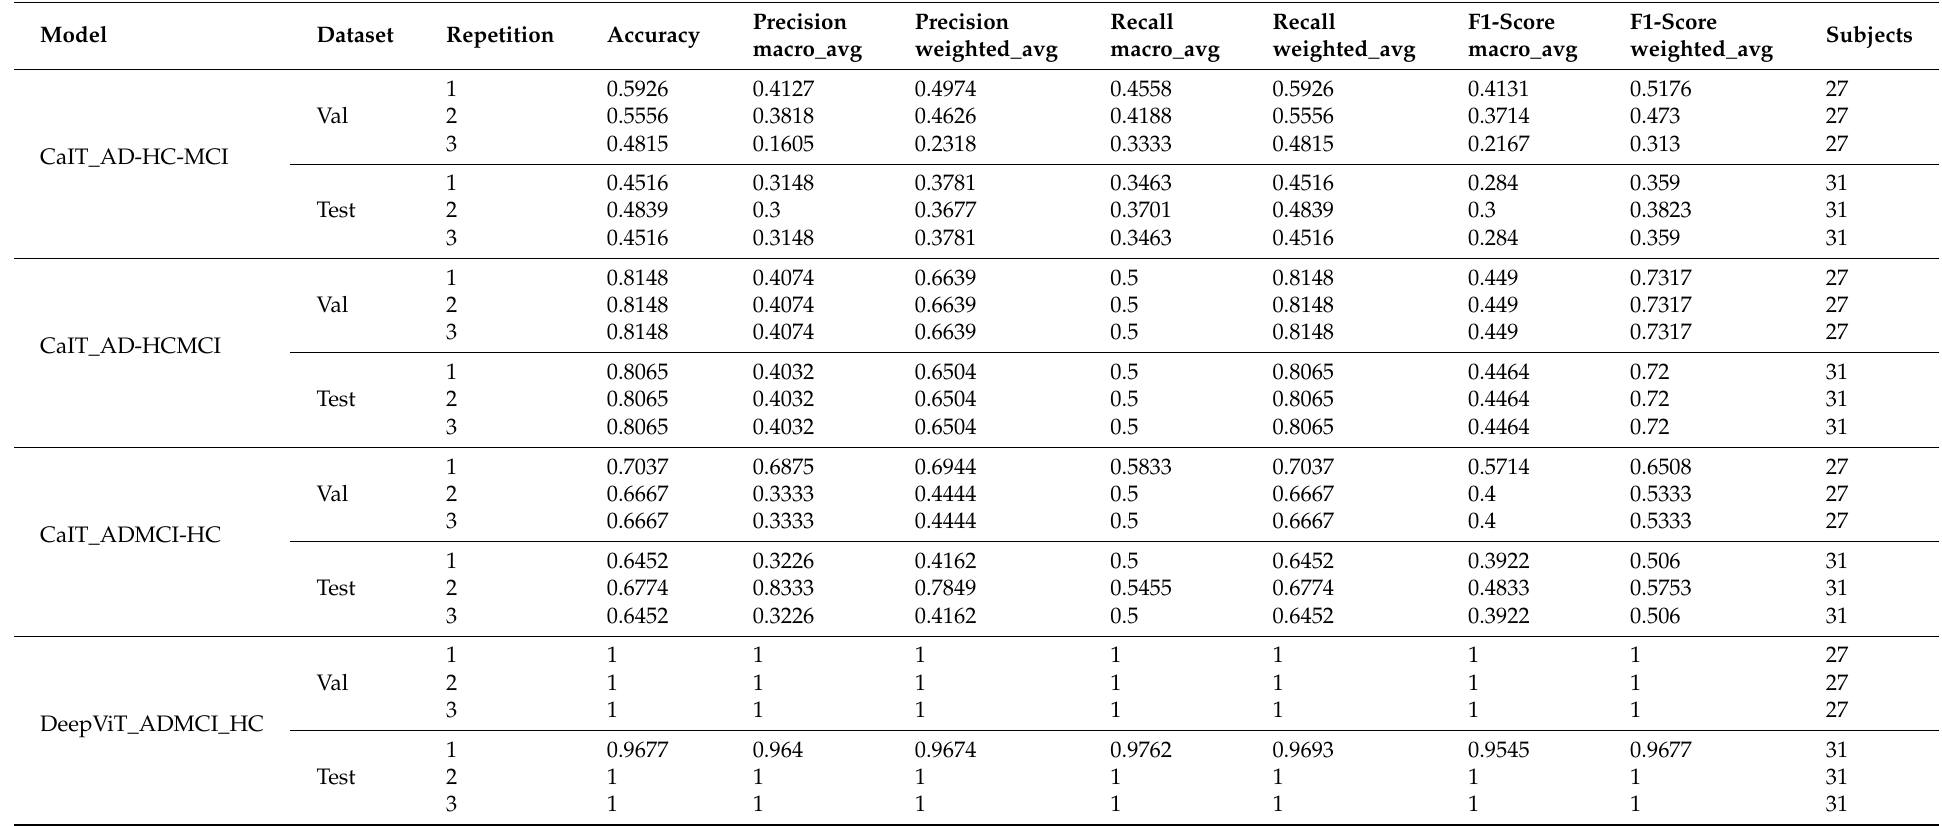
Table A2. The fMRI subject-level models’ performance is described in this table for the validation and test datasets and three repetitions (random data splits). The classification report includes the macro and weighted average precision, recall, and F1-score. The report also includes the accuracy rate and the number of unseen subjects aggregated by the postprocessing module and used for each model evaluation. In this table, AD-HC-MCI refers to multiclass (3-class) prediction, AD-HCMCI refers to AD vs. HC + MCI, and ADMCI-HC represents AD + MCI vs. HC binary